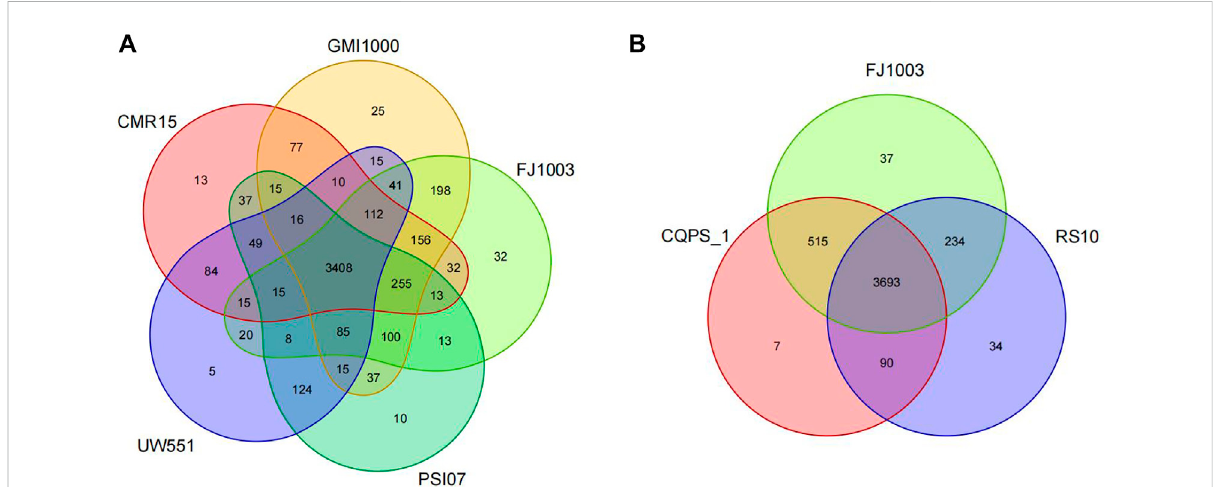
FIGURE 5 Venn diagrams showing the number of speci fi c and shared genes among the R. solanacearum strain FJ1003 and other bacterial species. (A) Venn diagrams of the sequenced strains and reference strains from different phylotypes. (B) The hosts of the three strains are tobacco. Note: the overlappingregions inthe fi gure indicatethenumberofgenefamilies shared amongthedifferentspecies, while theregions thatdo notoverlap with other species indicate the number of gene families speci fi c to that